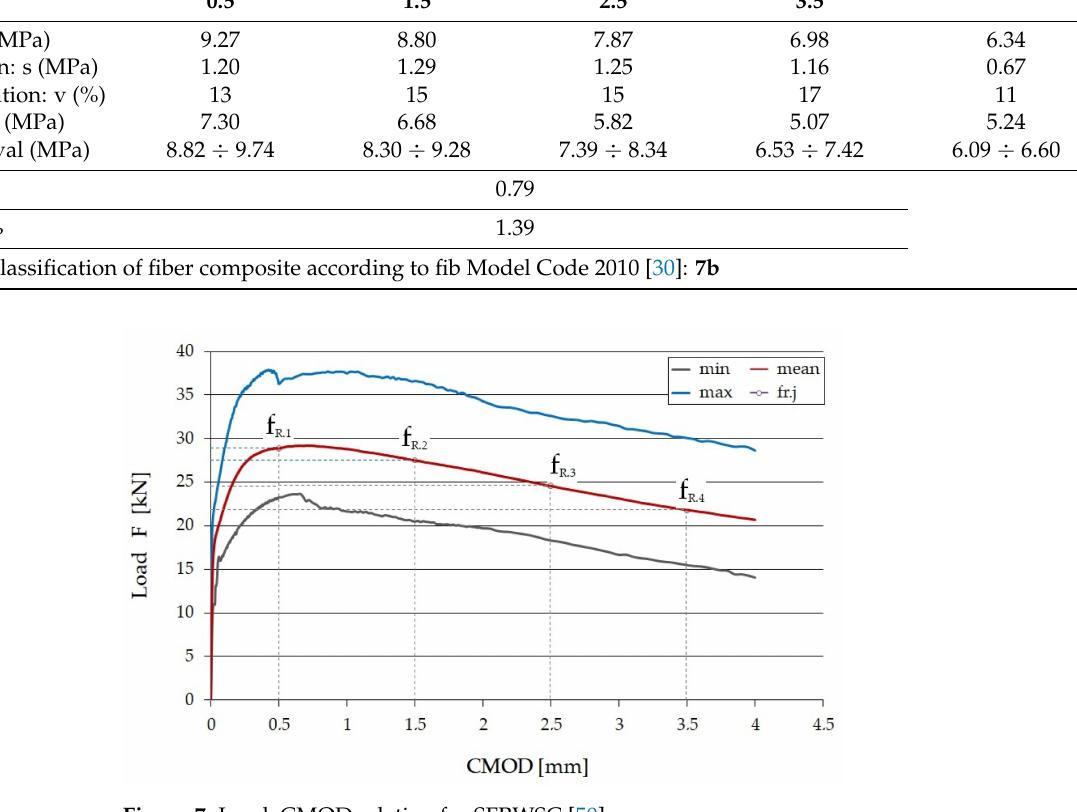
Figure 7. Load–CMOD relation for SFRWSC